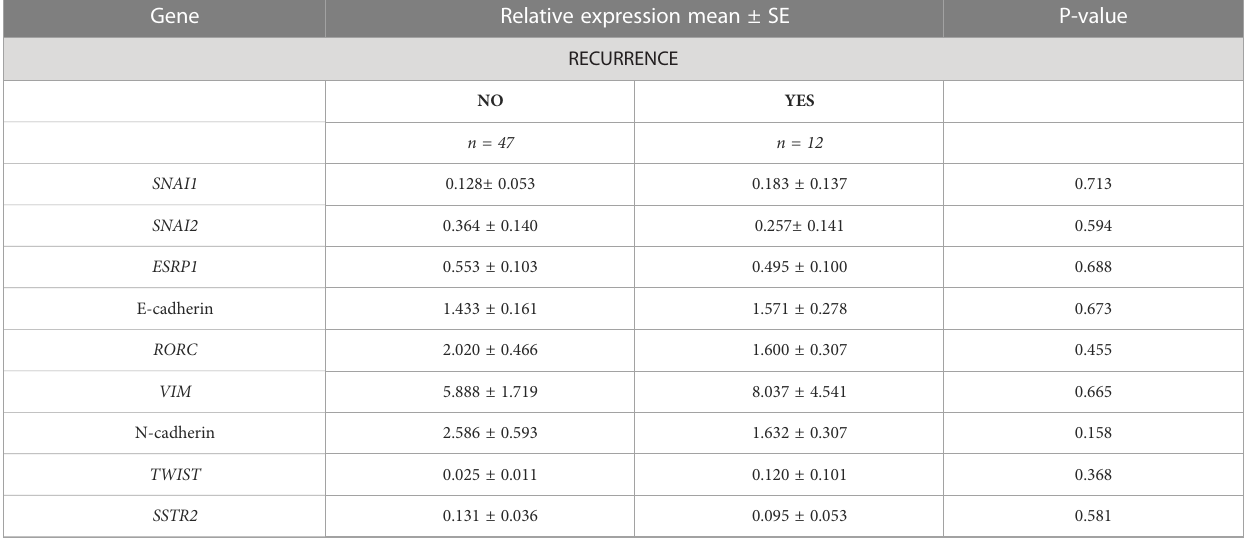
TABLE 4 Association between the relative expression of each gene and the development of a recurrence. Gene Relative expression mean ± SE